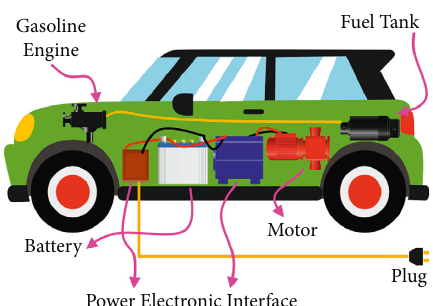
Figure 4: Plug-in hybrid electric vehicle.